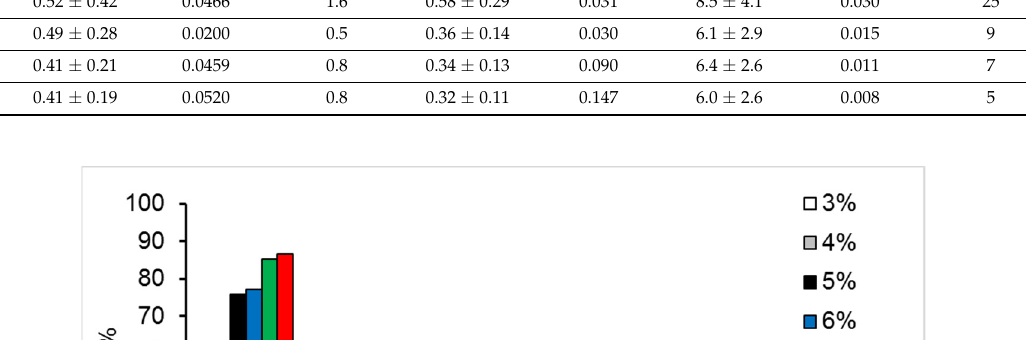
Figure 2. Pore size distributions for six studied materials with 3–8% Y 2 O 3 . Table 1. Average parameters of microstructure and fracture surface.